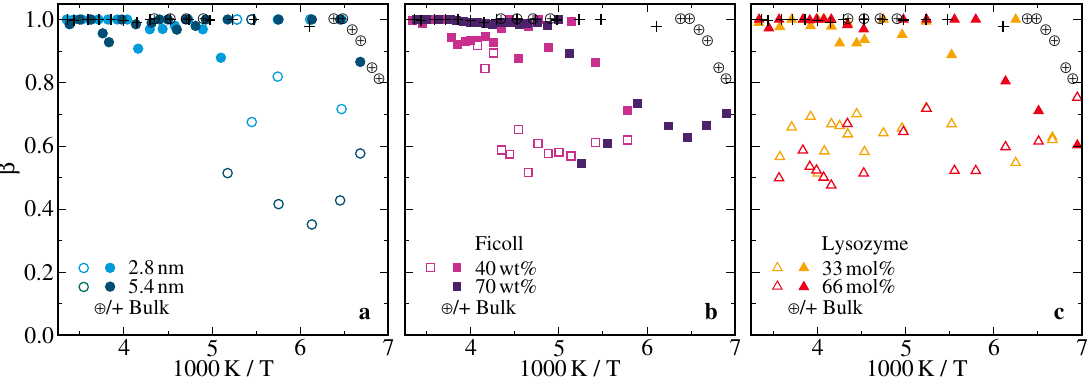
Figure 5. Temperature-dependent stretching parameters β n obtained from 2 H SLR studies on 66mol% D 2 O-DMSO- h 6 solution in ( a ) silica pores with diameters of d = 2.8nm and d = 5.4nm, ( b ) ficoll at solution mass fractions of w s = 70wt% and w s = 40wt%, and ( c ) lysozyme at a solvation level of s = 0.68 g sol / g lys . For the lysozyme matrix, results for a solution with 33mol% water are also included. In all panels, data for the 66mol% D 2 O-DMSO- h 6 bulk solution are shown for comparison, where present and previous [57] results are marked by crosses and circled crosses,